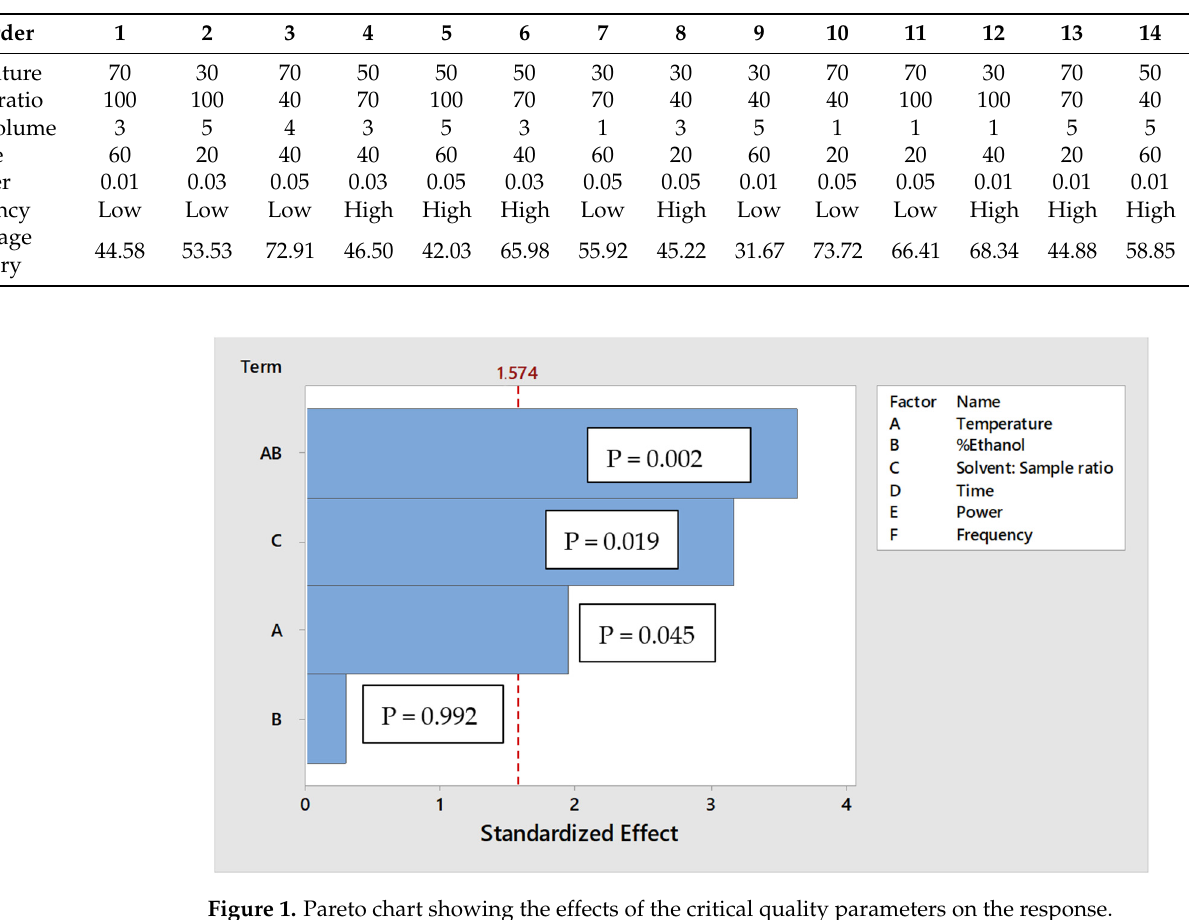
Figure 1. Pareto chart showing the effects of the critical quality parameters on the